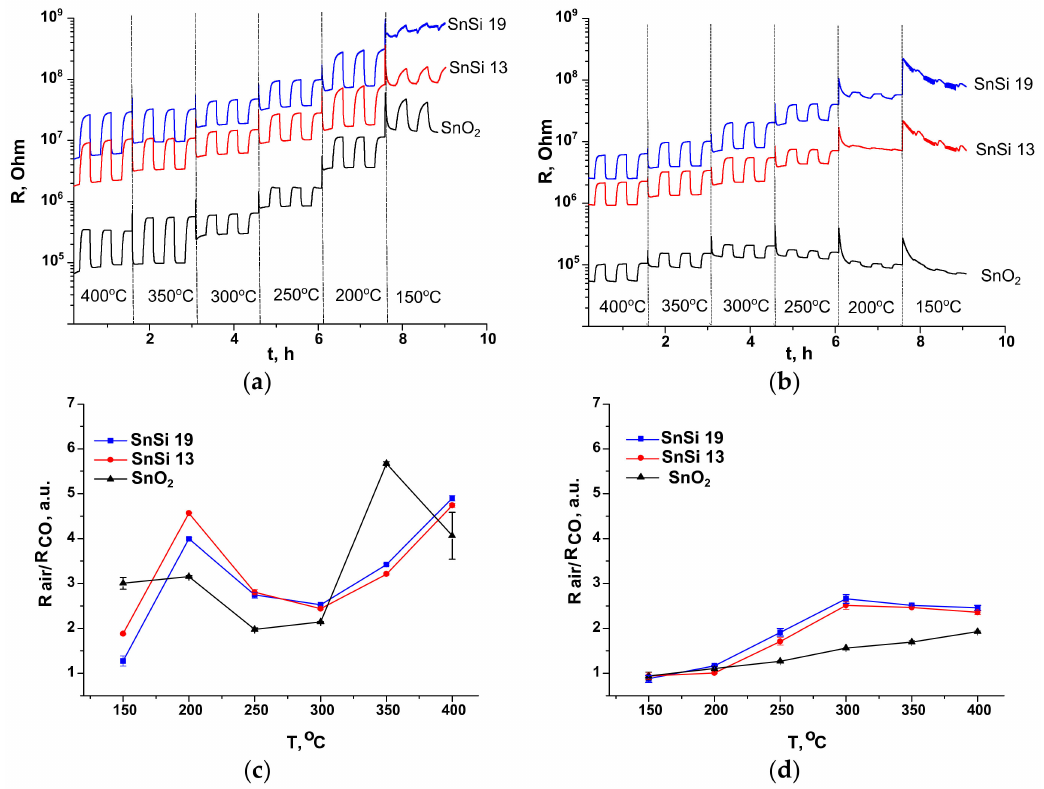
Figure 10. Resistance of nanocrystalline SnO 2 and SnO 2 /SiO 2 nanocomposites in the temperature range 400–150 ◦ C under the periodic change of the gas phase composition: ( a ) RH = 1%; ( b ) RH =